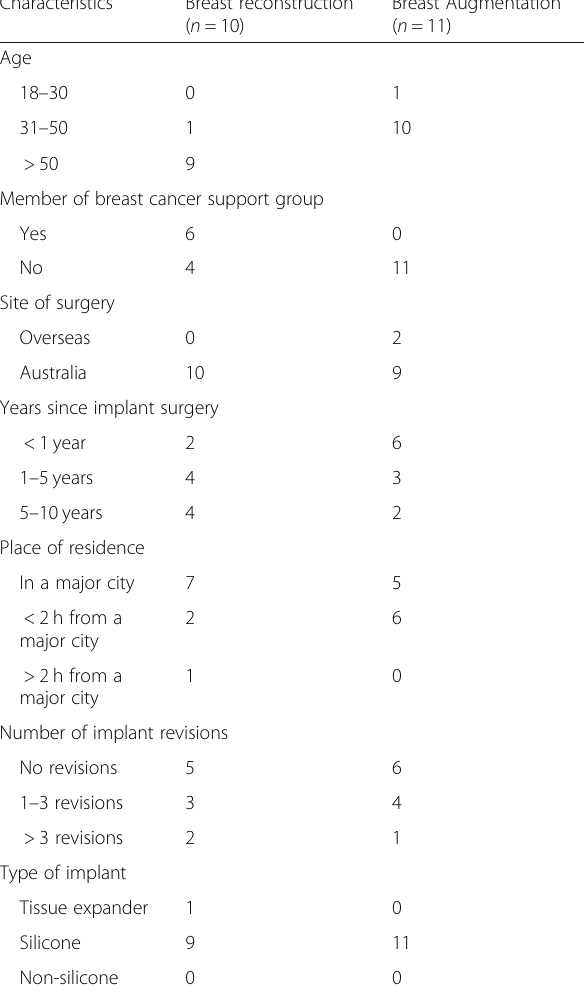
Table 1 Characteristics of recipients of breast implants